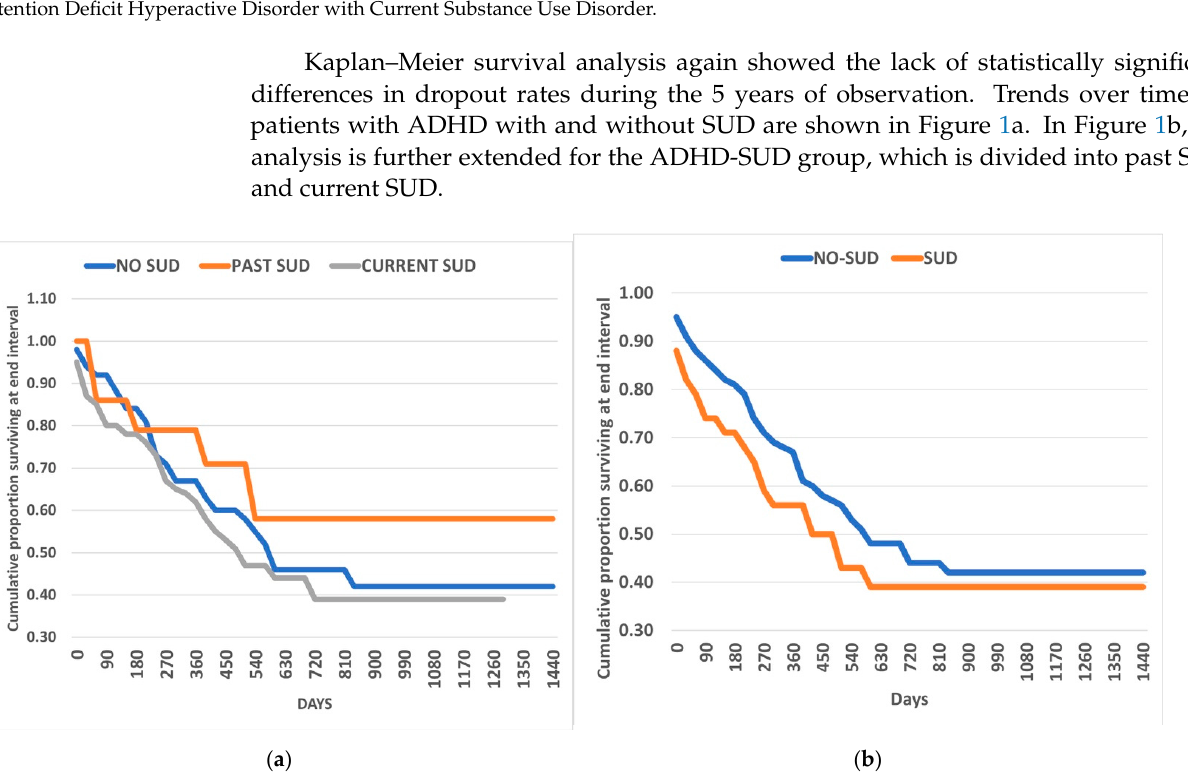
Table 3. Correlation between negative outcome to treatment and associate covariates in 118 A- ADHD study participants.